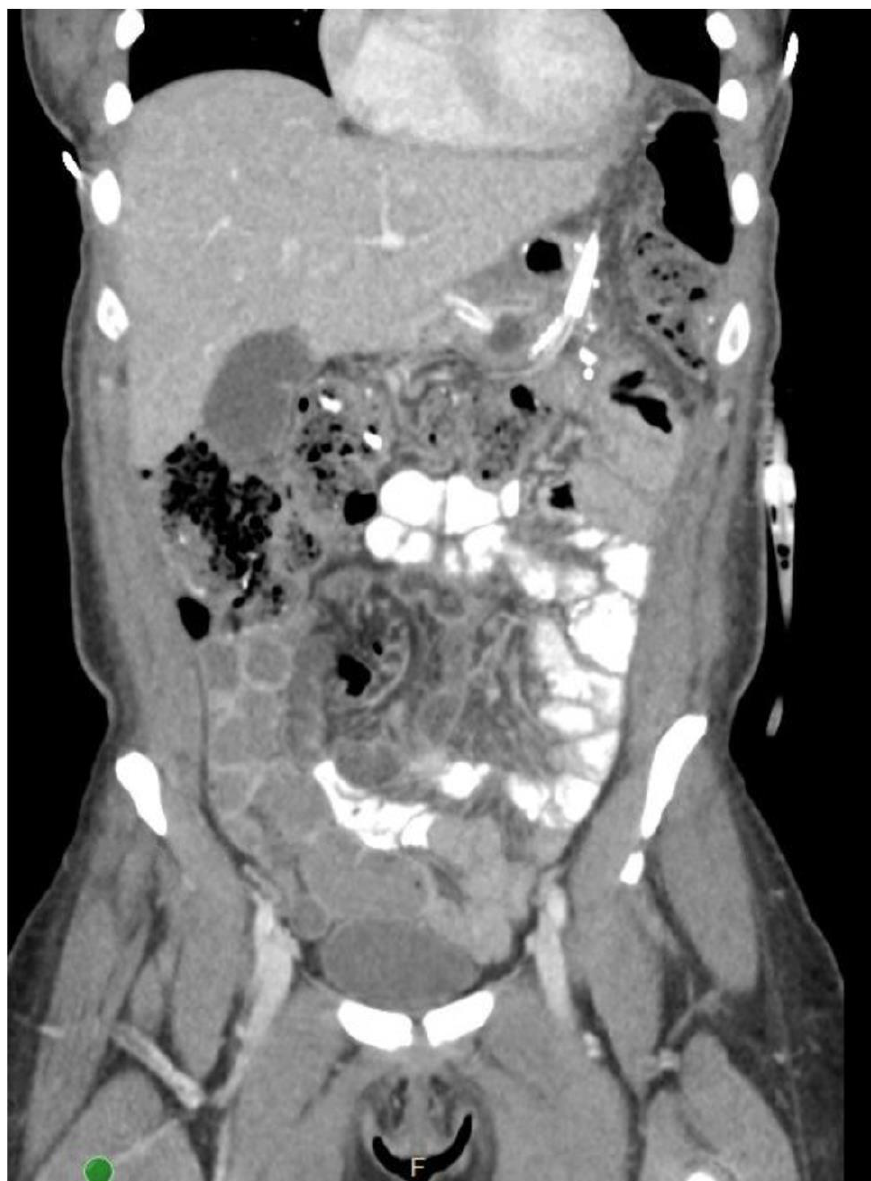
Figure 4. Abscess drained and remnant G-tube placed (not visible) after laparoscopic surgery. The patient was evaluated in clinic 10 days later, at which time her remnant gastros- tomy was clamped due to low output. She returned two weeks after that, and a repeat sinogram showed a small fistula between a portion of the remnant stomach and the sur- gical drain (Figure 5). This area did not connect with the proximal gastric pouch or the alimentary